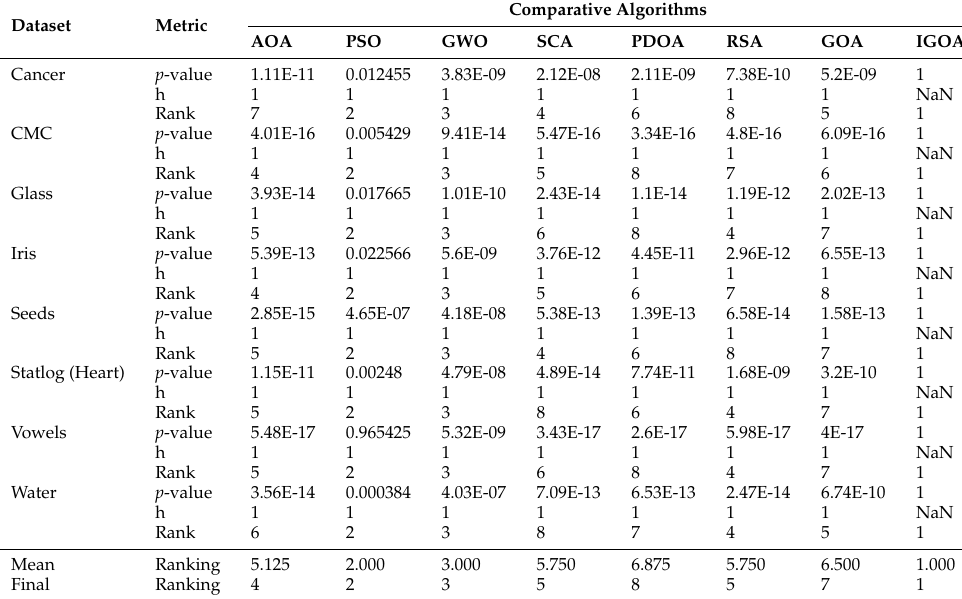
Table 14. The statistical test using the p -value, Wilcoxon rank test, and Friedman ranking test.